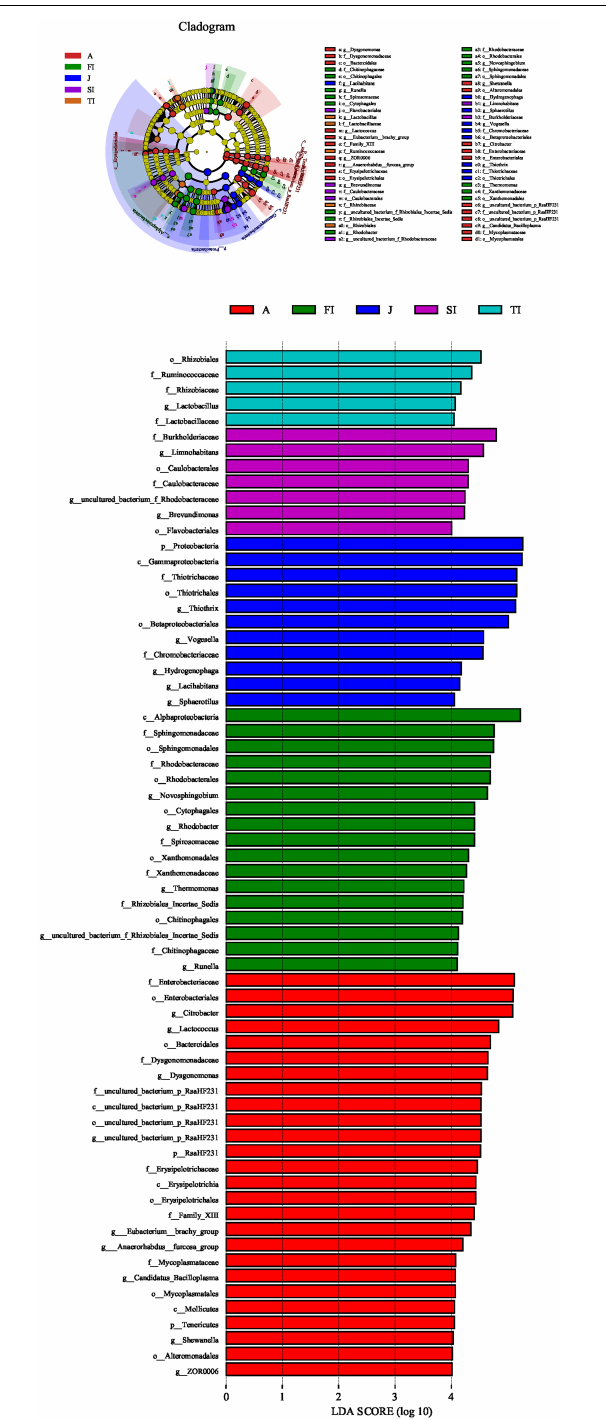
FIGURE 6 | Linear discriminant analysis taxonomic cladogram showing the discriminatory taxa at each development stage of crayfish. The figure shows the taxa whose linear discriminant analysis score was higher than 4.0. The discriminatory taxon nodes were colored, and the branch areas were shaded according to the highest-ranked group for that taxon. If the taxon was not significantly differentially represented among sample groups, the corresponding node was colored